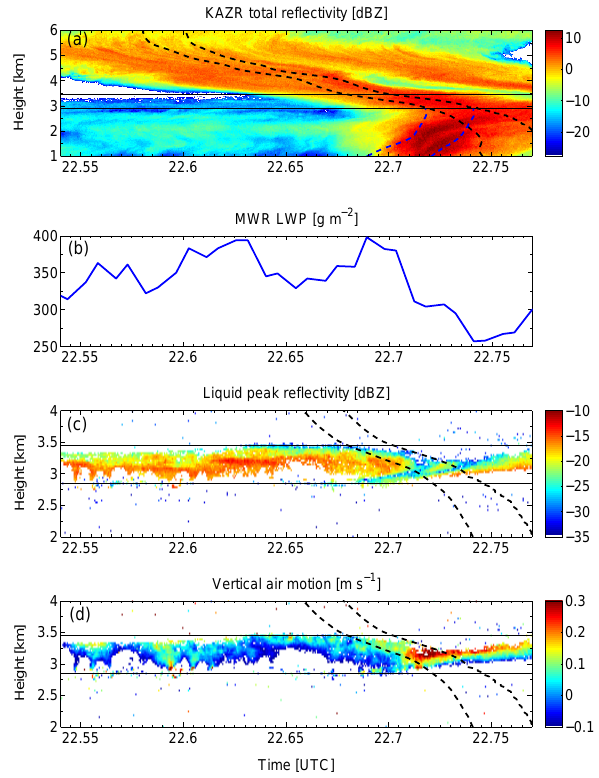
Figure 5. Zoomed view (2–4km, 22.54–22.77UTC) of the snow front on 21 February 2014. Panel (a) shows KAZR total reflectiv- ity, (b) microwave radiometer (MWR) liquid water path (LWP), (c) reflectivity of the liquid peak, (d) mean Doppler velocity of the liquid peak used as vertical air motion tracer. The dotted lines depict individual fall streaks starting at different generating levels z gen (z gen = 6km (black), z gen = 2 . 9km (blue)). All subsequent av- eraged profiles refer to the area between the two black fall